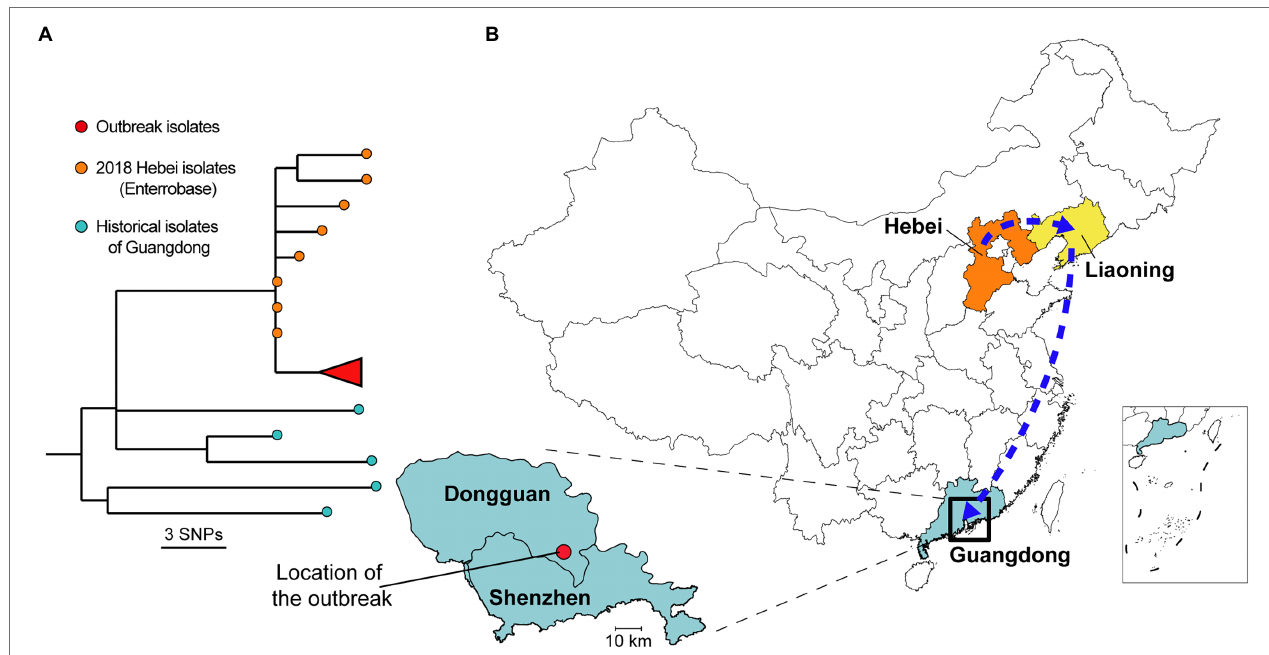
FIGURE 4 | Possible transmission dynamics of the Salmonella Enteritidis clone throughout a multi-provincial egg distribution network in China. (A) Maximum likelihood tree of outbreak isolates ( n = 66), historical isolates ( n = 5, SNP distance < 22), and Enterobase isolates ( n = 8, cgMLST loci difference < 10). Colored circles in the tree tips indicate geographical origins corresponding to the map in the right panel. (B) Inferred transmission dynamics for the possible origins of a S . Enteritidis clone implicated in the current outbreak. This clone appeared to have originated from an egg producer in the Hebei province, with a possible transmission chain that included intermediary distributors in the Liaoning province, before being sold at wholesale markets in Dongguan, Guangdong province, which in turn gave rise to the current disease outbreak in